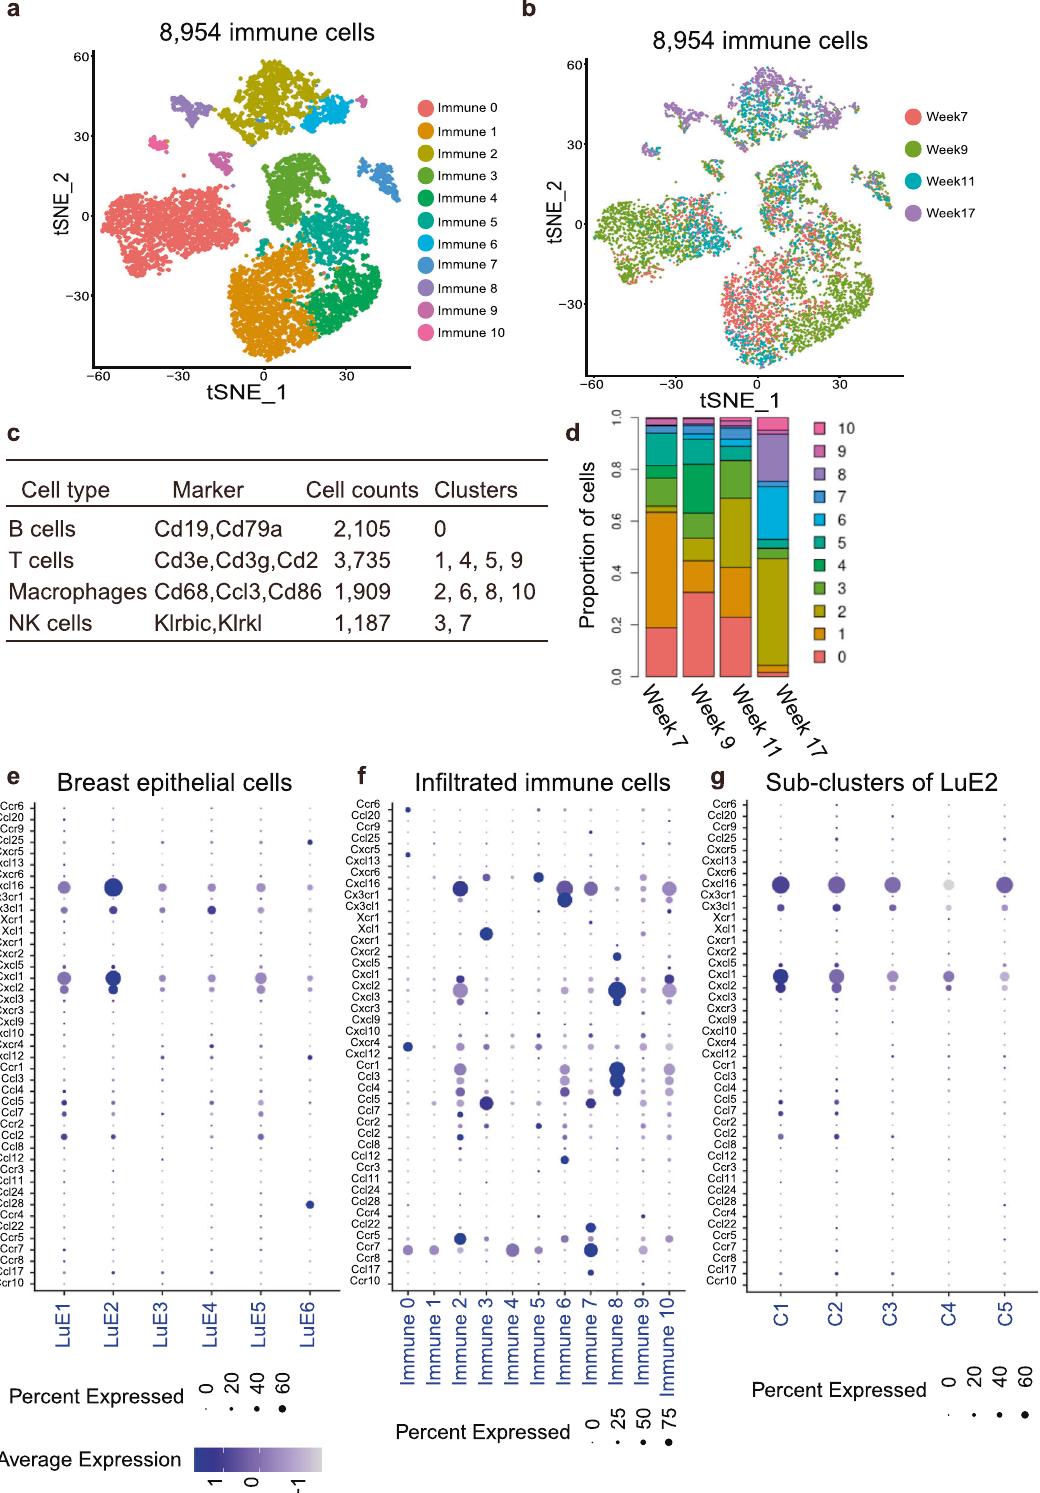
Fig. 7 The cross-talk between BCSCs and immune cells during tumor progression. a , b The t-SNE plot showed the distribution of the immune cells from different clusters supervised by Seurat ( a ) and different tumor progression stages ( b ) in the atlas. c A table showed the markers used to annotate immune cells and cell accounts of the corresponding cell type. d Dynamic changes of the proportion of the immune cell types spanning from premalignant to late carcinoma. e – g Dot plots showed the expression of paired cytokine and cytokine receptors in ER low clusters, immune clusters and sub-clusters of LuE2, which indicated that cytokine Cxcl1 and Cxcl16 were highly expressed in sub-clusters of LuE2 and the corresponding receptors Cxcr2 and Cxcr6 were highly expressed in macrophages and T cells.